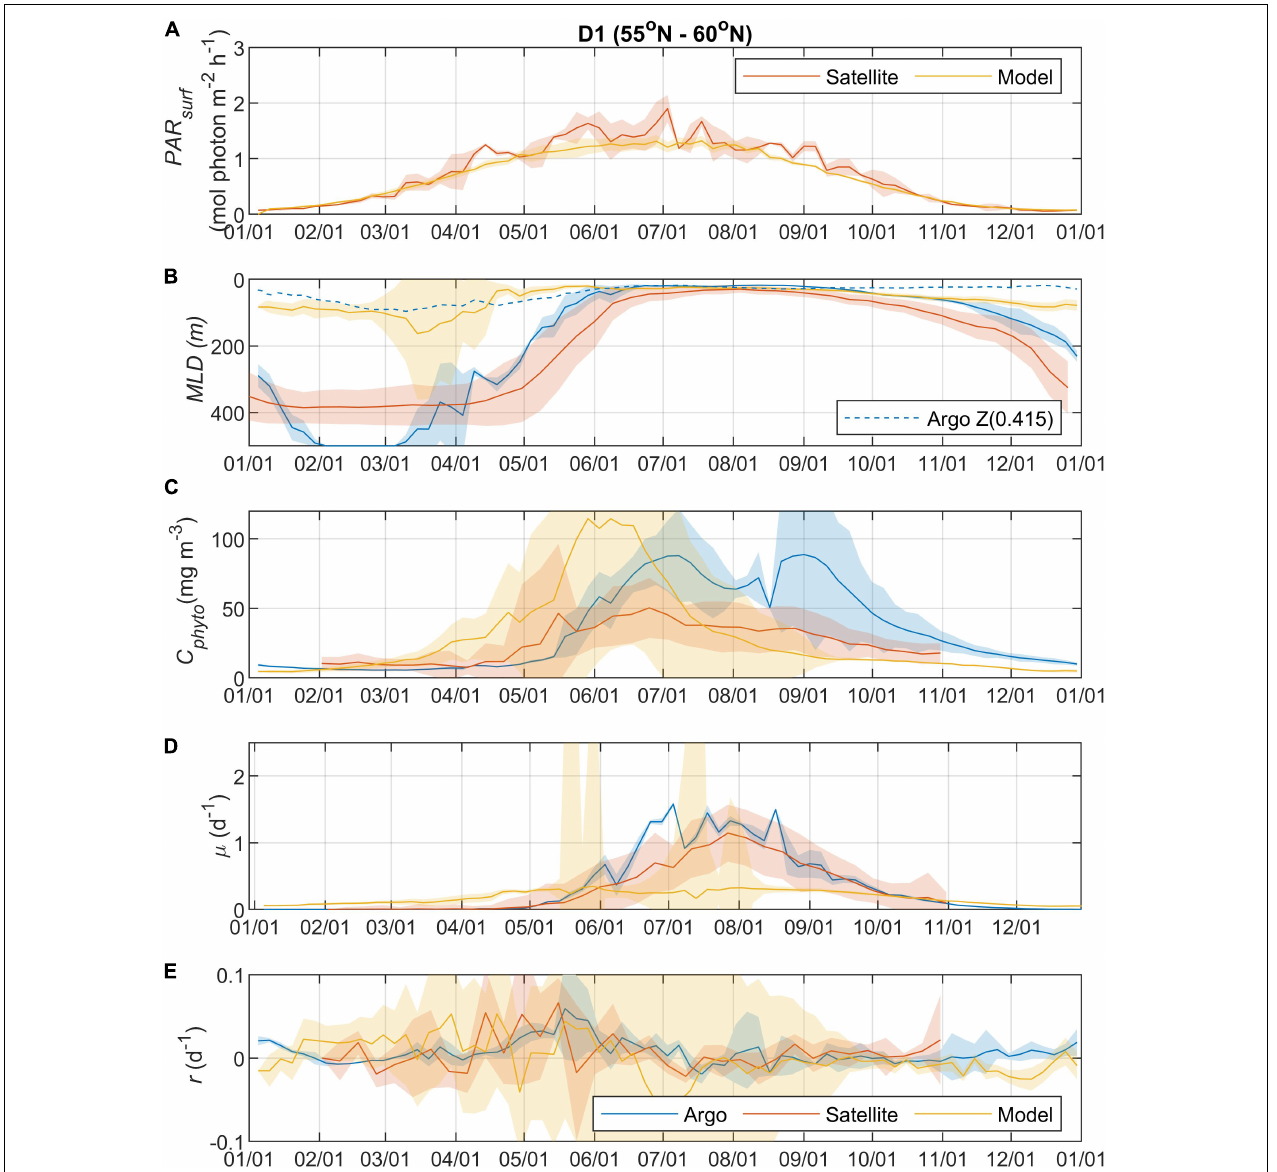
FIGURE 2 | Seasonal climatologies of (A) surface photosynthetically active radiation ( PAR surf ), (B) mixed layer depth ( MLD , m), (C) mixed layer phytoplankton carbon biomass ( C phyto , mg m − 3 ), (D) mixed layer phytoplankton specific division rate ( µ , d − 1 ), and (E) mixed layer phytoplankton net accumulation rate ( r , d − 1 ) from Argo floats, satellite, and model simulation (blue: Argo, red: satellite, yellow: model) for region D1 (see map in Figure 1 for region boundaries). Note that the MLD used in satellite algorithm came from HYCOM. The lighter shadings represent one standard deviation. The dashed blue line in panel b represents the isolume depth Z(0.415) derived from Argo measurements (see section “Float Data” for